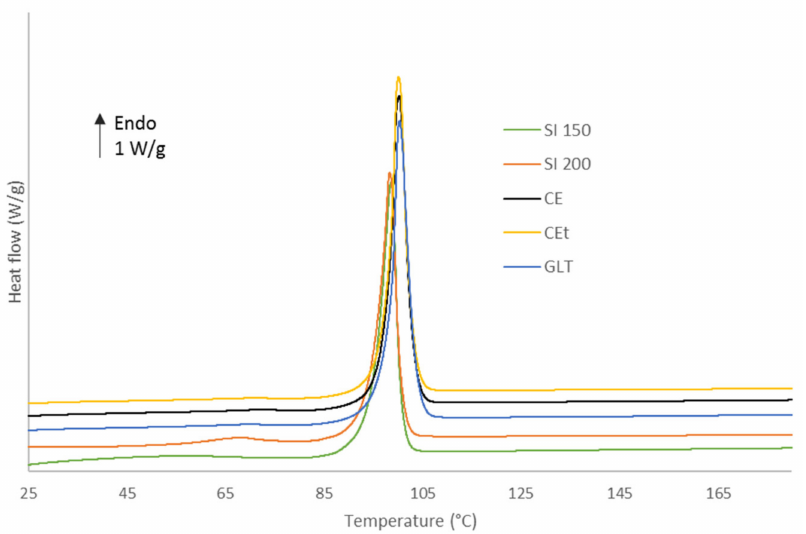
Figure 6. DSC thermoanalytical curves of D-Sorbitol CE [41], CE T , SI150, SI200 and GLT powders. Each of the D-Sorbitol used in the formulation had different particle sizes and shapes.